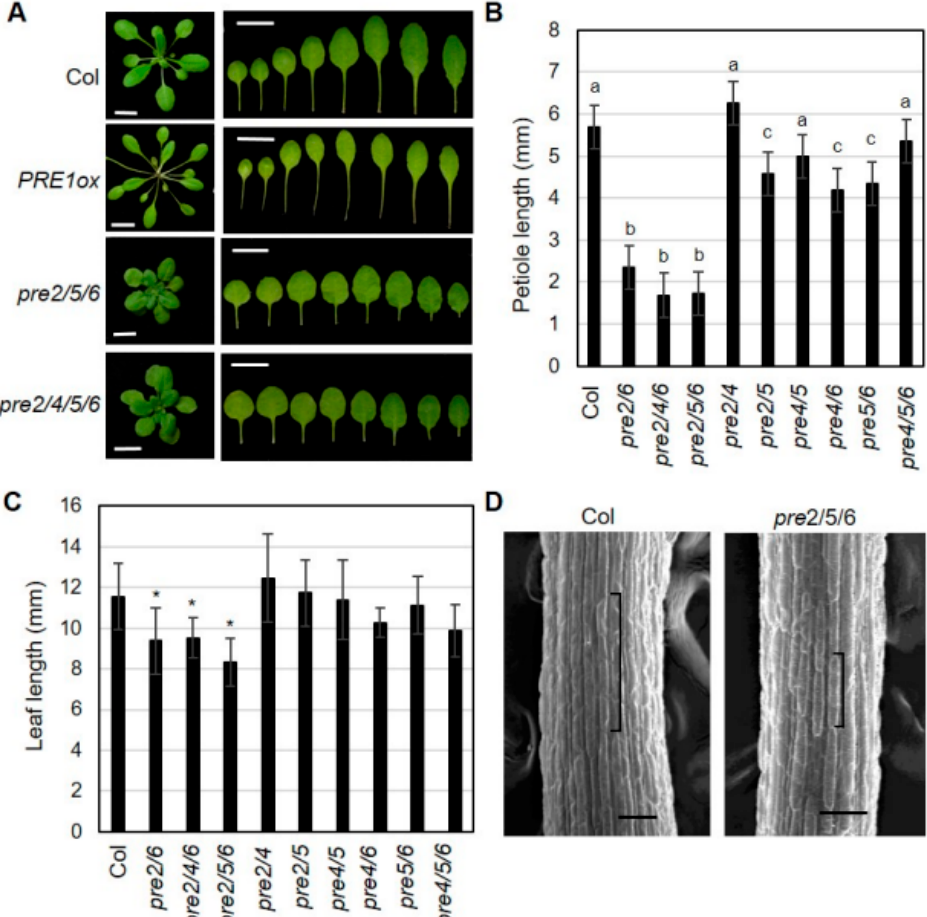
Figure 1. High order loss-of-function of PRE s alters leaf growth. ( A ) Representative leaf morphology of pre mutants. The pictures were taken from 3 week-old plants. The leaves were arranged according to the age from left to right. Scale bar, 1 cm. ( B ) Petiole length of pre mutants. The petiole length was measured with the 7th leaves of 3 week-old plants grown under long-day (16 h light/8h dark). Values are mean ± SD ( n = 12–15). Significant difference among wild type (Col) and mutants are indicated with letters (ANOVA, Tukey HSD test, p < 0.05). ( C ) Leaf length was analyzed from the same leaves as described in B. Values are mean ± SD ( n = 12–15). A significant difference between wild type (Col) and mutants is indicated with asterisks ( t -test, * p < 0.01). ( D ) Cell length of petiole epidermis. Petioles of the third leaf of wildtype (Col) or pre2pre5pre6 were subject to scanning electron microscopy. Brackets indicate the lengths of single epidermal cells from the middle of petioles. Scale bar, 100 μ m.